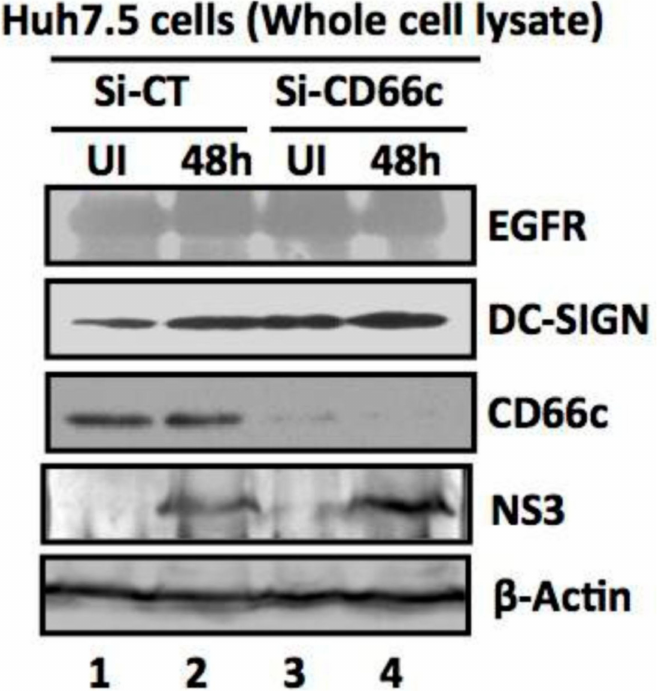
Figure 12. siRNA knockdown of CD66c in Huh7.5 cells have not inhibited entry of another non-IAV virus (Hepatitis C virus, HCV). Here, Si-CT denotes control siRNA treated human hepatoma cells; Si-CD66c are human hepatoma cells treated with CD66c siRNA. Cells are either left uninfected (UI) or infected with 0.5 MOI of HCV for 48 h (48 h). Human hepatoma cells harvested 48 h post infection are subjected to immunoblotting. The figure shows that CD66c siRNA treated human hepatoma Huh7.5 cells show reduced expression of CD66c (third panel from top). However, this siRNA-mediated knockdown of CD66c in Huh7.5 cells does not inhibit HCV entry as determined by the expression level of HCV viral protein NS3 (fourth panel from top). Huh7.5 cells knocked down for CD66c expression do not show any inhibitory effect in the expression levels of EGFR and DC-SIGN (upper two panels). β -Actin is loading